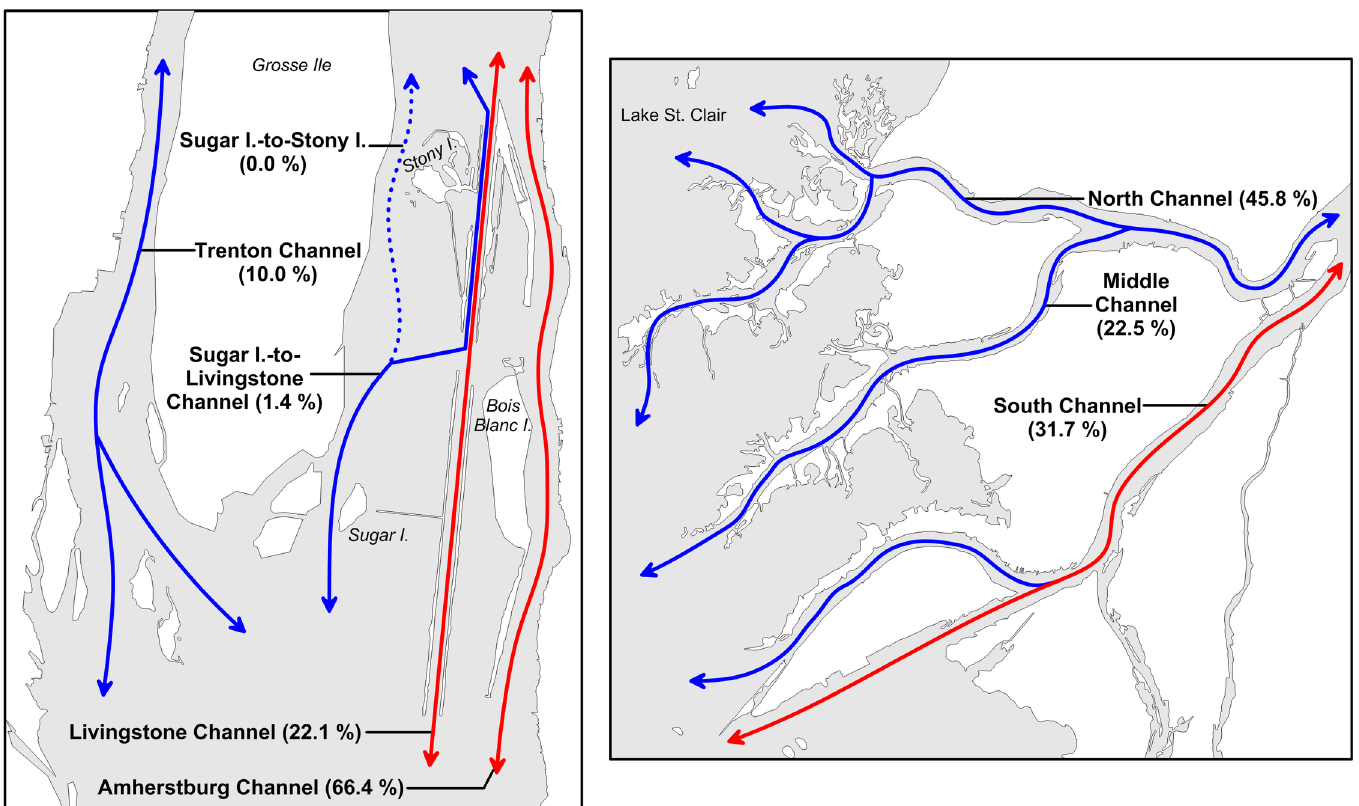
Fig 5. Path use (% of observed passages) by acoustic-tagged Lake Sturgeon in the lower Detroit (left panel) and St. Clair (right panel) rivers. Total number of passageswas 280 in the lower Detroit River and 404 in the lower St. Clair River. Movement pathways through navigation channelsare shownin red. Lake Sturgeonmoving upstream at Sugar Island in the lower Detroit River turned eastwardand entered the Livingstone navigation channel(solid path) rather than continuingalongthe expectedpath (dashedextension)towards Stony